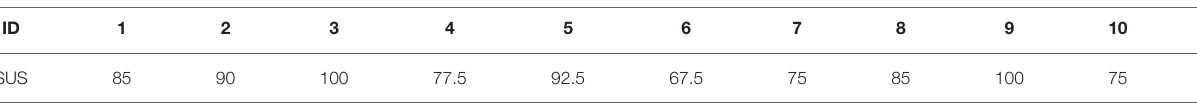
TABLE 6 | Subject’s system usability total scores.